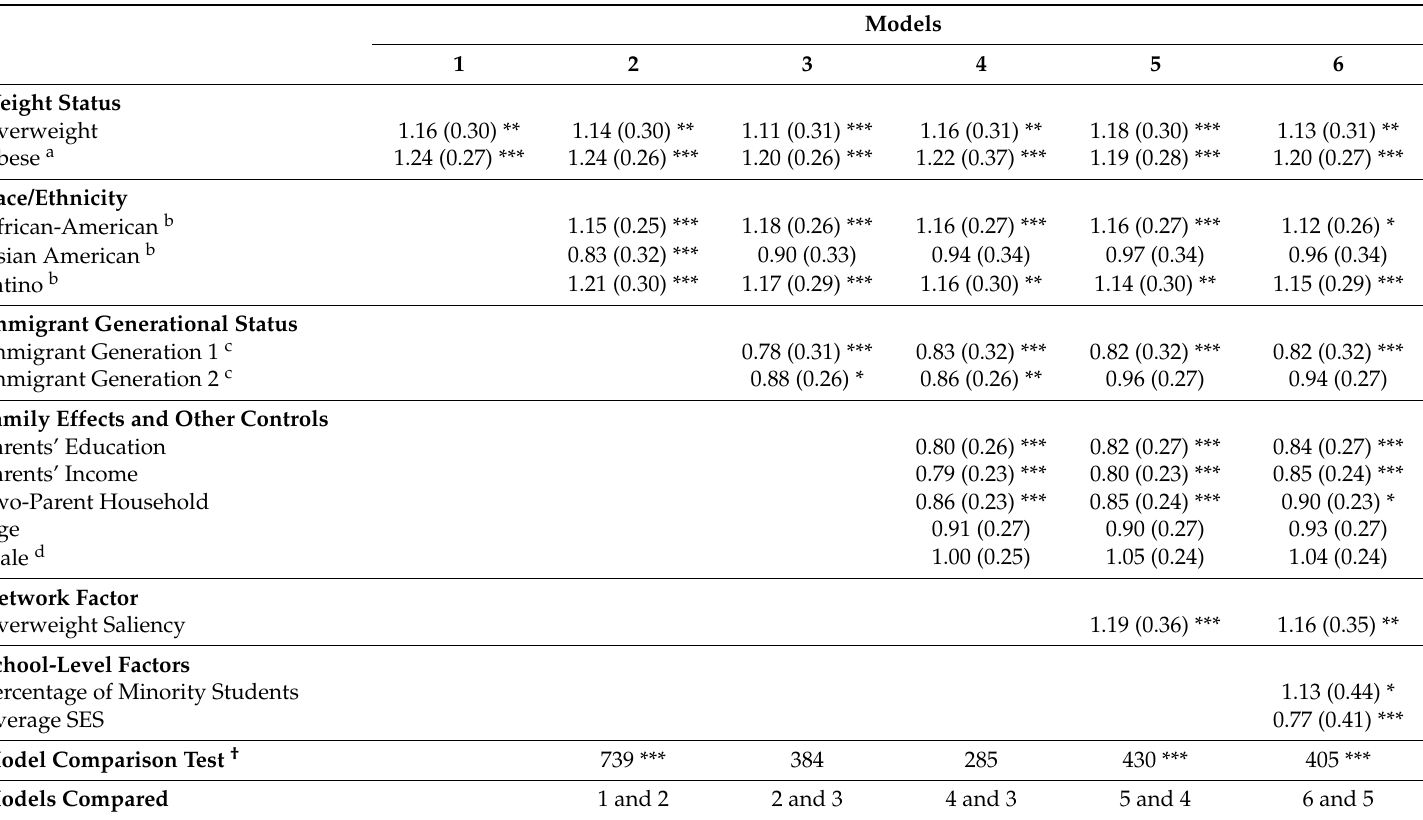
Table 2. Predictors of high school graduation: odds ratios and their standard errors (in